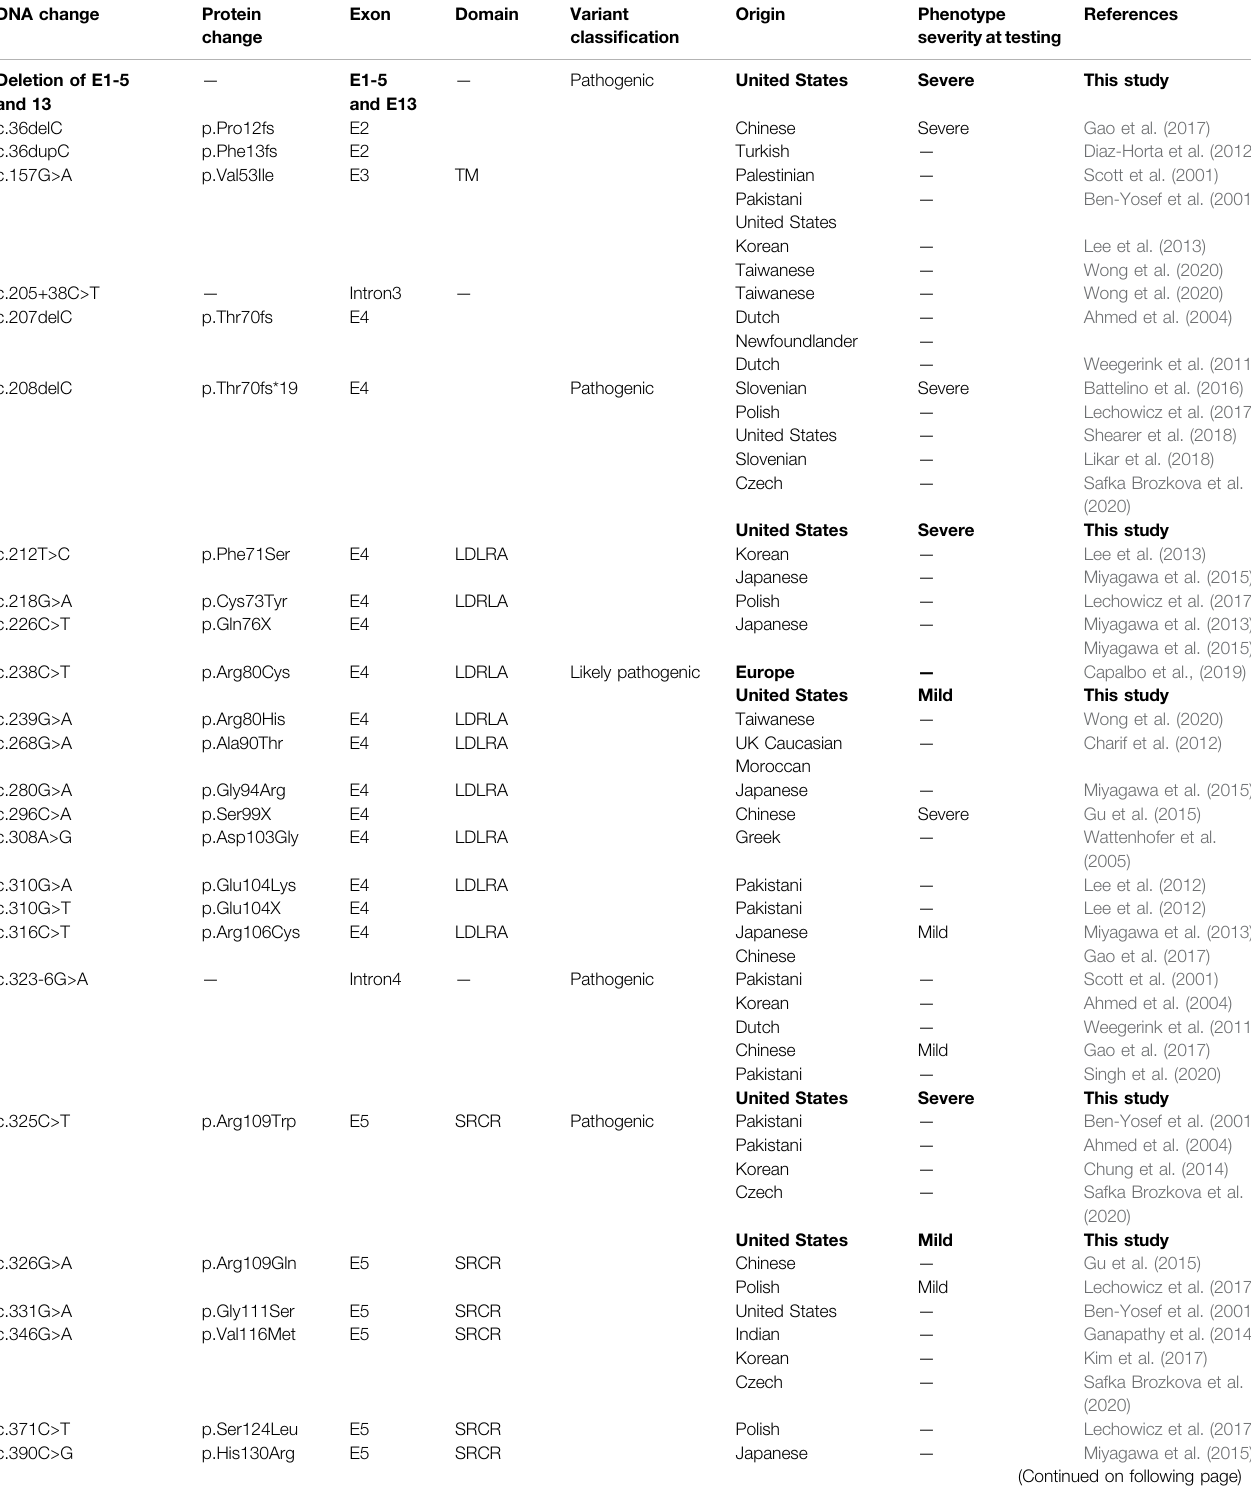
TABLE 1 | Overview of TMPRSS3 variants resulting in non-syndromic hearing loss, including those identi fi ed in the present